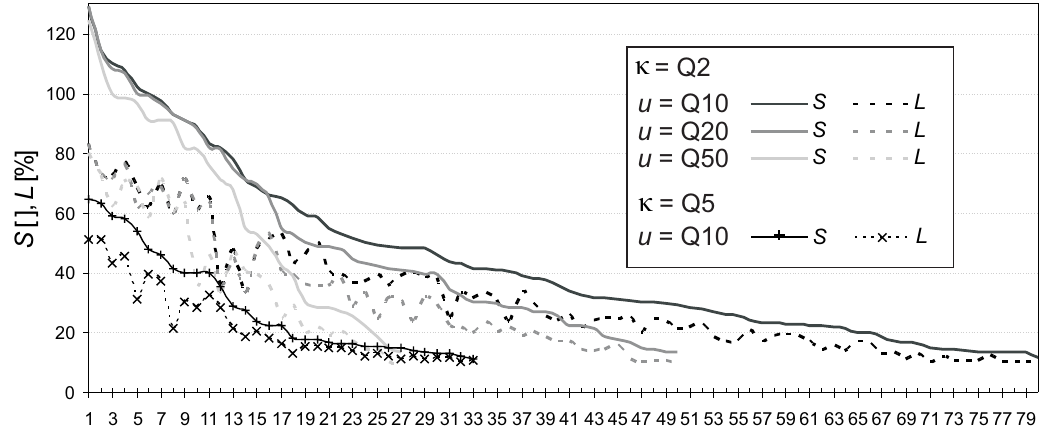
Fig. 10. Comparison of event sets using various u ( p =0.9, 0.95, 0.98) and κ ( p = 0.5, 0.8). The temporal envelope W = [3,10] is the same for all examples. The ranks indicate the number of events and their relative location in the set according to the severity indicator S , but between the sets the same rank may not refer to one and the same